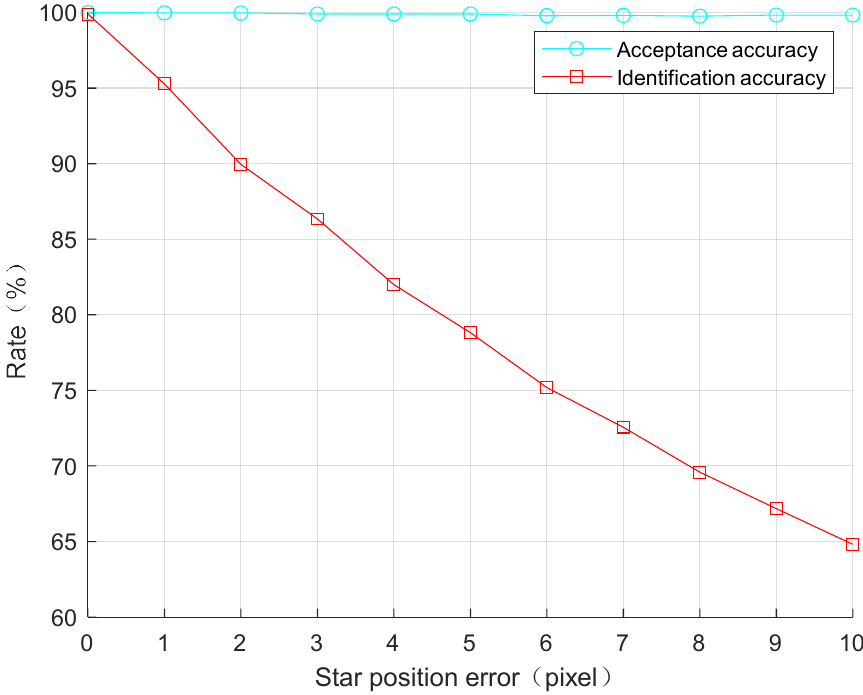
Figure 16. Acceptance accuracy and identification accuracy sensitivity to star positioning errors.